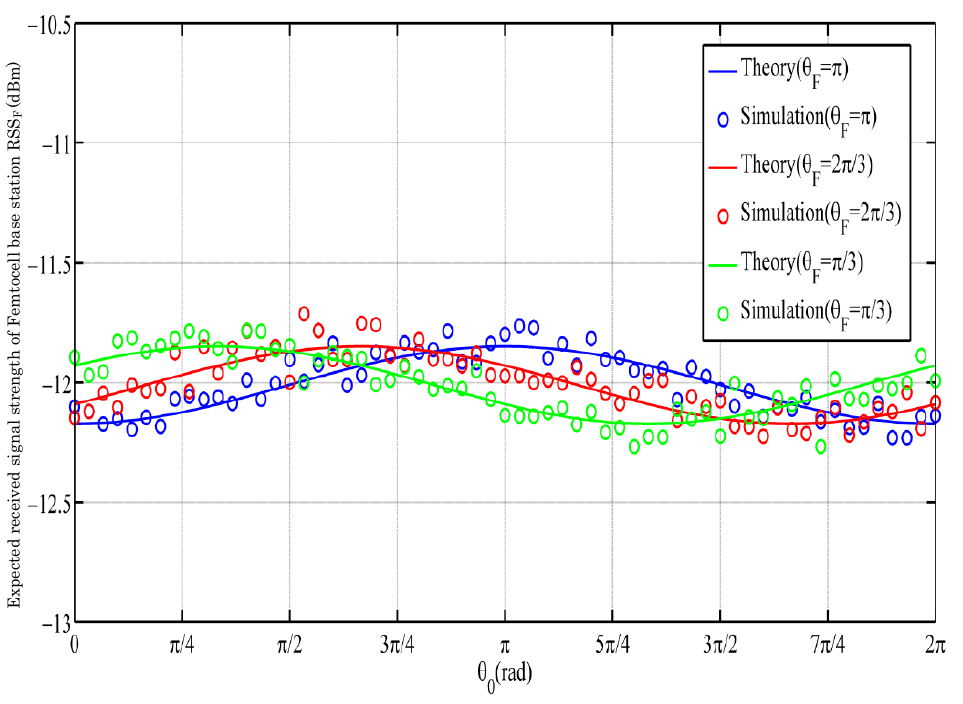
Figure 11. When r = 4.5 m/s, expected received signal strength of femtocell base station RSS F